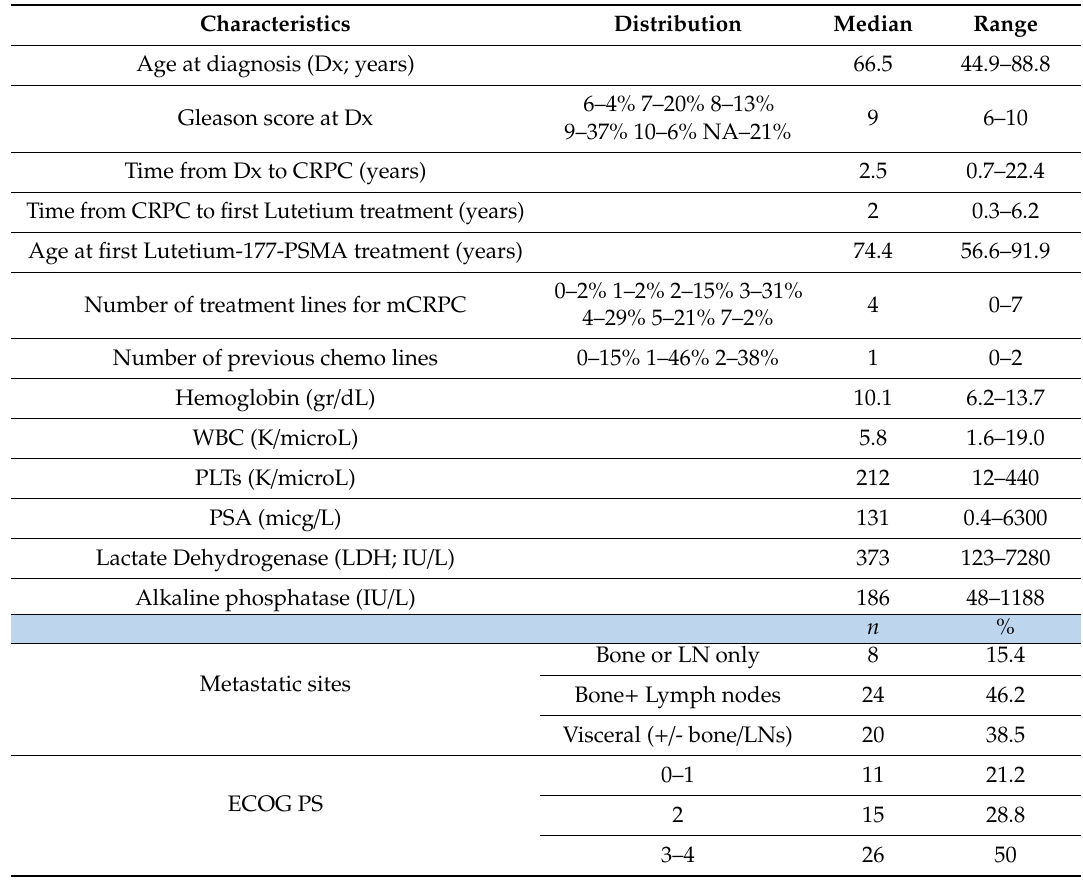
Table 1. Patient